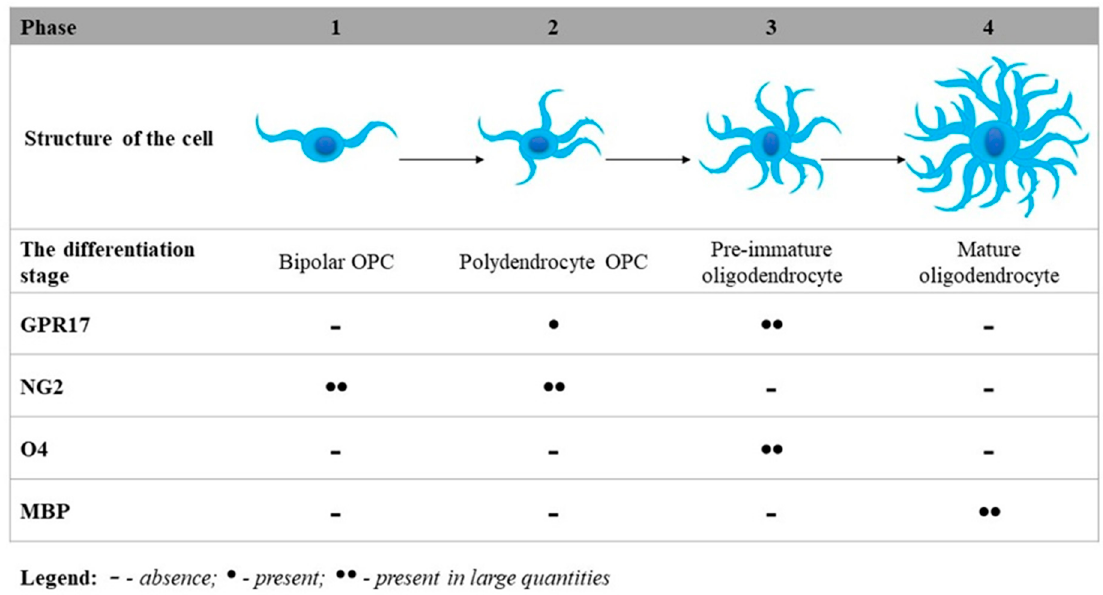
Figure 2. Phases of GPR17 differentiation. GPR17 as an inner timer of oligodendrocyte differentiation and the myelination process. GPR17 is expressed in the oligodendrocyte lineage cells, and its level is increased during differentiation of NG2+ OPCs into O4 ‐ pre ‐ myelinating oligodendrocytes. It is evidently downregulated during the terminal maturation of myelinating oligodendrocytes, which express MBP.